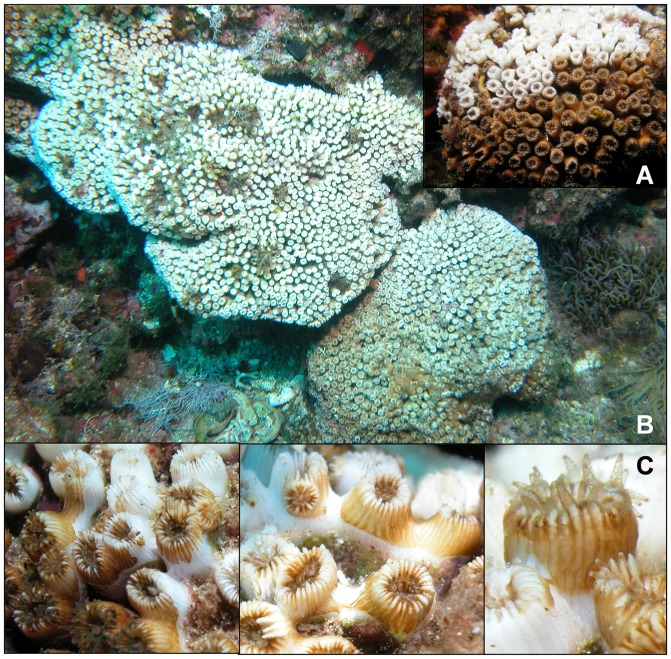
Mortality of C. caespitosa.A. C. caespitosa colony showing partial necrosis. B. Totally affected colony. C. The necrosis process in the polyps of C. caespitosa.